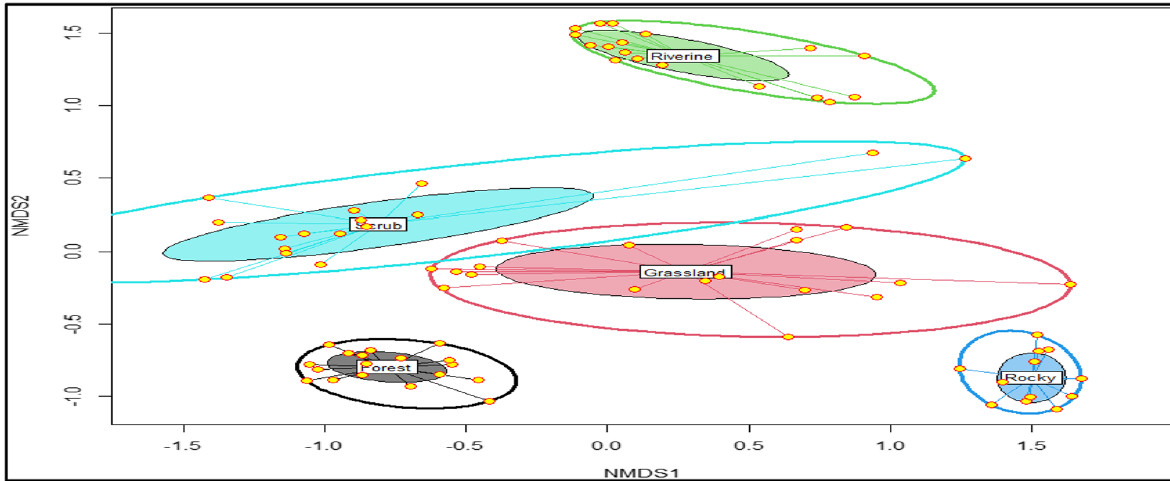
Fig. 6 Non-metric Dimensional Scaling (NMDS) plot showing difference in bird species composition between studied vegetation or land use types. The size of each ellipse is proportional to within-group dissimilarity of the given vegetation or land use category while as the degree of overlap between the two ellipses shows the associated community similarity between their respective vegetation or land uses